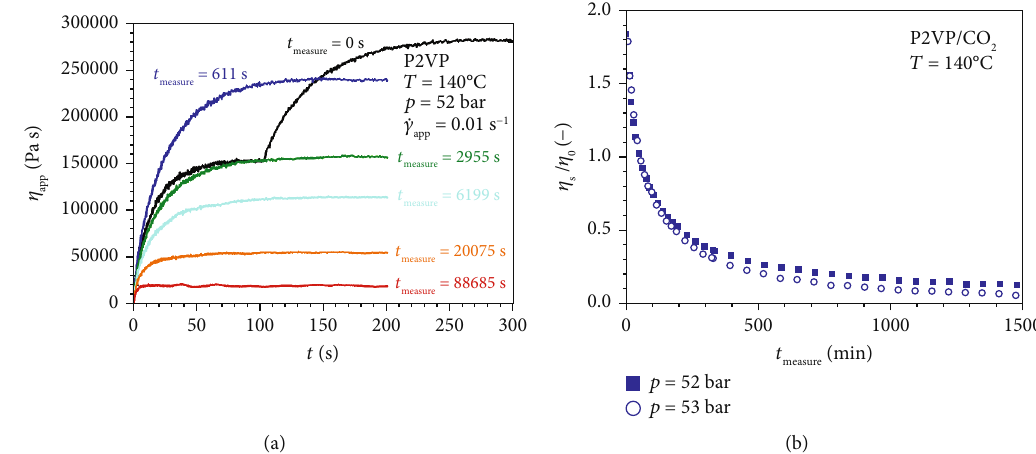
Figure 14: Example of a typical rheological experiment at high pressure in a CO time-dependent shear viscosity η with respect to zero shear rate viscosity η